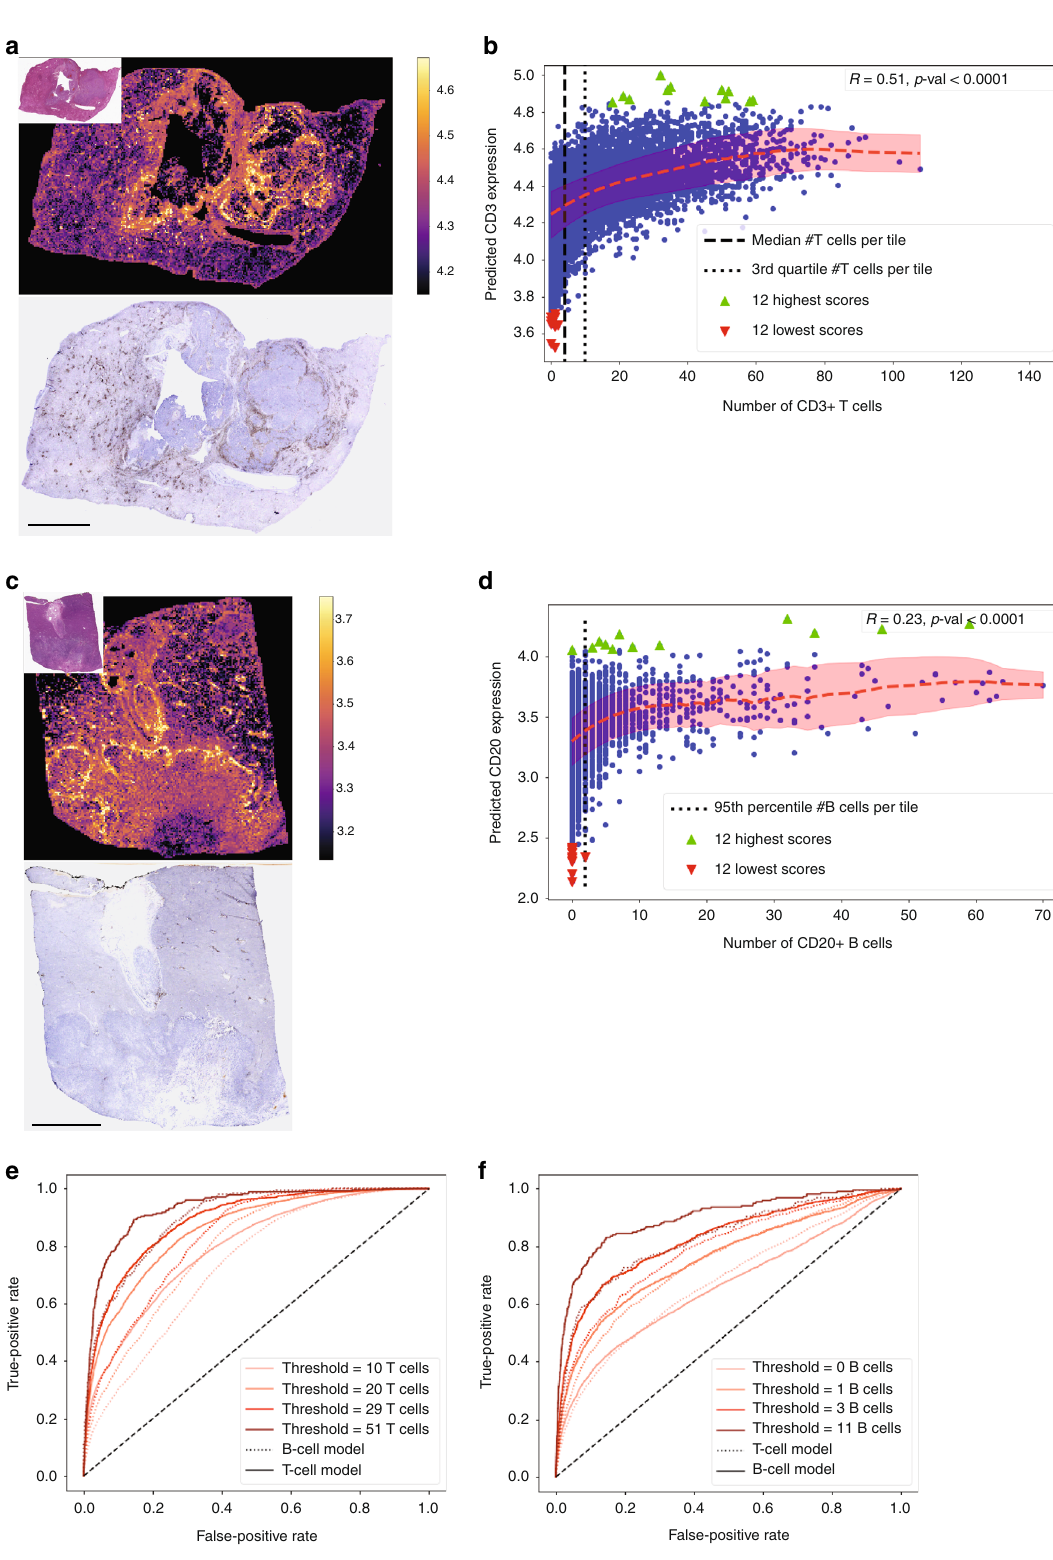
value AUC average = 0.65 and a median value AUC median = 0.67, the Barcelona Clinic Liver Cancer (BCLC) stage 48 . For